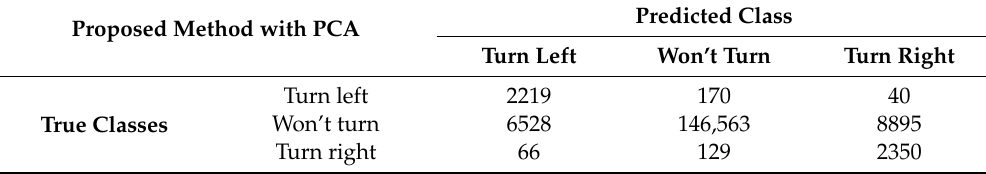
Table 11. The confusion matrix of the proposed method with PCA with 0.1 s prediction